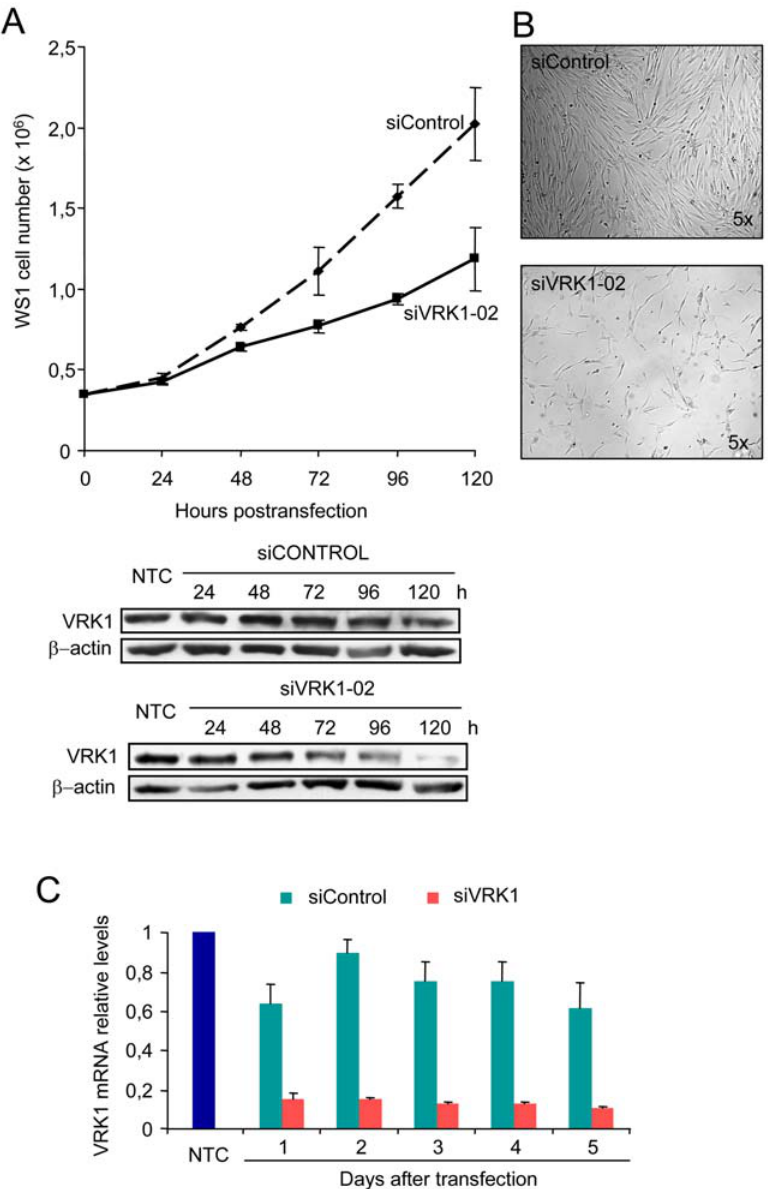
Figure 7. Effect of siRNA on endogenous VRK1 and cell proliferation. (A). Proliferation of WS1 cells that were transfected with siRNA control or siRNA specific for VRK1. The total cell number in the dish was determined at different time points (top). The endogenous protein was detected in an immunoblot (bottom) (B) Photograph of the WS1 cell cultures treated with siRNA control (top) or siVRK1 (bottom). The proliferation is much slower in cells transfected with the specific siVRK1. These experiments were independently performed three times. (C). Effect on VRK1 RNA levels in WS1 cells transfected with either siControl or siVRK1. NTC: non transfected cells.